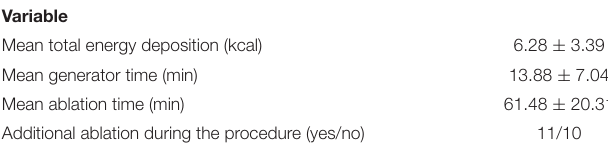
TABLE 1 | Baseline characteristics of the patients and nodules. TABLE 2 | Nodule treatment